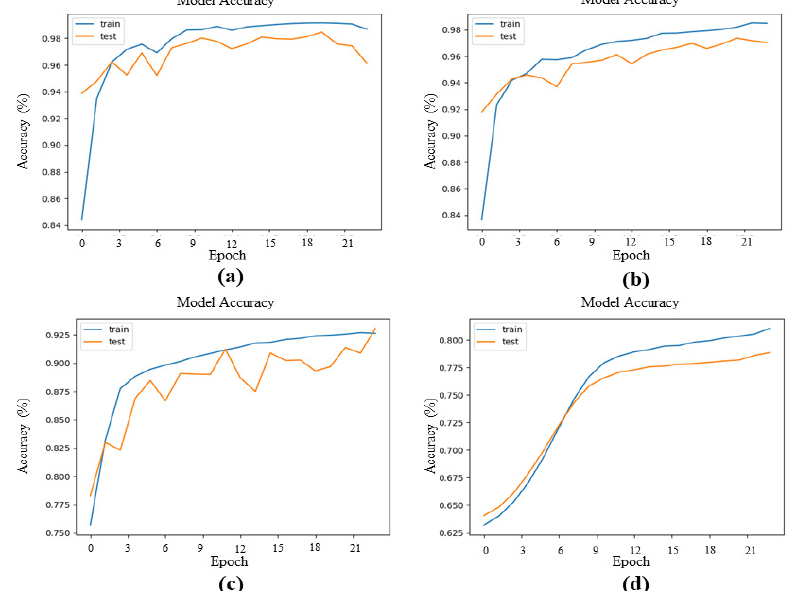
Figure 5. Accuracy on the training and test sets using different learning rates ( α ). ( a ) accuracy with α = 10 − 4 ; ( b ) accuracy with α = 10 − 5 ; ( c ) accuracy with α = 10 − 6 ; ( d ) accuracy with α = 10 − 7 .